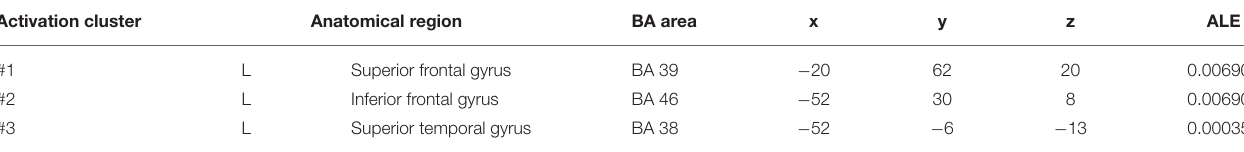
TABLE 6 | Clusters with PD > HC activation in cue-priming